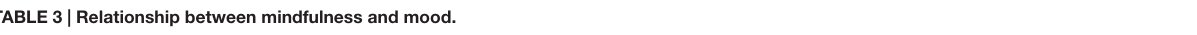
TABLE 3 | Relationship between mindfulness and mood. FFMQ Observing FFMQ